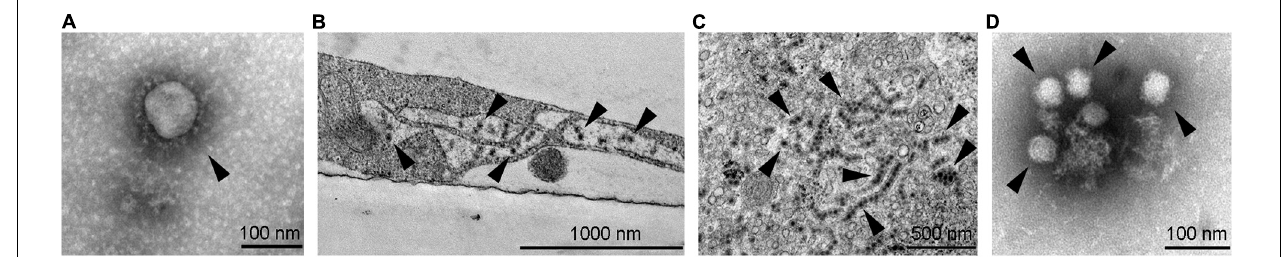
FIGURE 1 | Transmission electron micrographs of selected neurotropic viruses. (A) SARS-CoV-2 (marked by arrowhead) isolated on Vero E6 cells, ultracentrifuged onto formvar coated with carbon stabilized grids and negatively stained by using 2% phosphotungstic acid. (B) West Nile viruses (marked by arrowheads) in an infected SK-N-SH cell; the image shows an Epon embedded ultrathin section contrasted with uranyl acetate and lead citrate. (C) Zika virus (see arrowheads, strain Uganda 976) in an infected Vero E6 cell; the image shows an Epon embedded ultrathin section contrasted with uranyl acetate and lead citrate. Strings of viruses represent virus localization within endoplasmic reticulum. (D) Tick-borne encephalitis virus (marked by arrowheads) isolated on Vero E6 cells, ultracentrifuged onto formvar coated with carbon stabilized grids and negatively stained using 2% phosphotungstic acid. Electron micrographs were obtained by transmission electron microscope (JEM-1400 Plus, JEOL, Tokyo, Japan) at 120